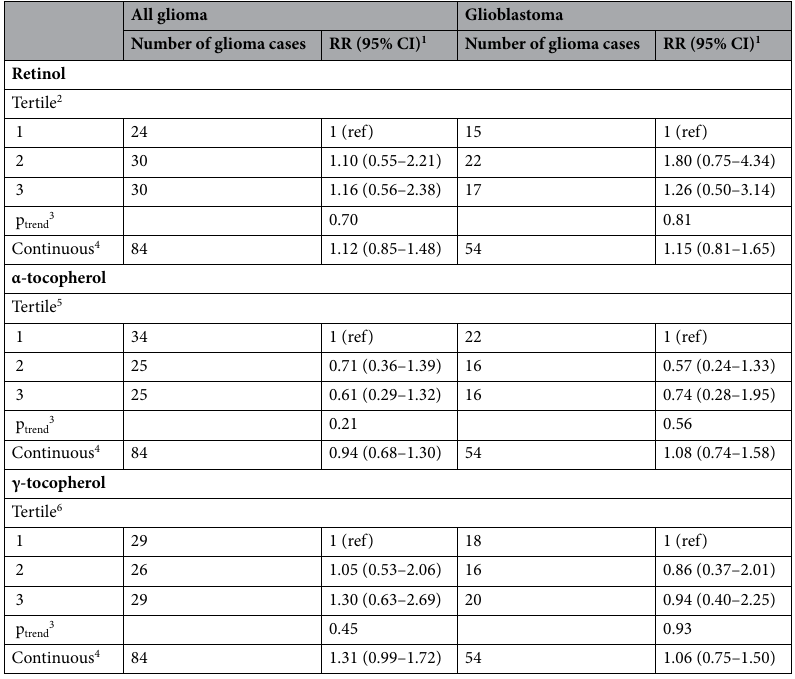
(Supplementary Table S5) and after excluding current smokers (Supplementary Table S6). Stronger associations were observed after excluding cases (and their matched controls) diagnosed within the first four years after blood collection (MVRR tertile 3vs.1 : 0.46 for α-tocopherol and 1.42 for γ-tocopherol) though estimates remained nonsignificant (Supplementary Table S6). Given the association between γ-tocopherol and GBM was different from that for total glioma, we analyzed its association with non-GBM and found a twofold higher risk per SD increment in γ-tocopherol (MVRR = 2.10, 95% CI 1.12–3.93, n = 30 cases).